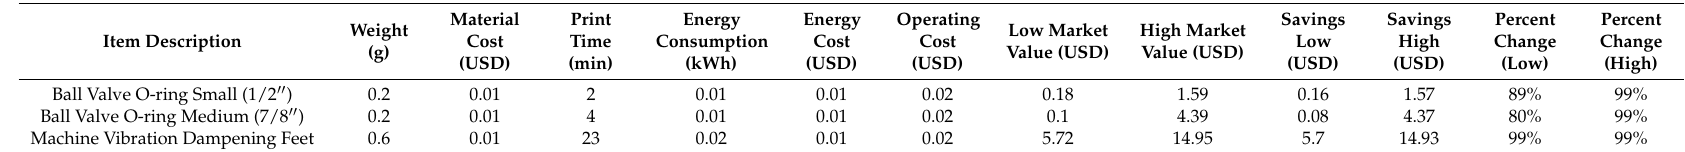
Table 4. Recycled TPE Filament 3-D Printed